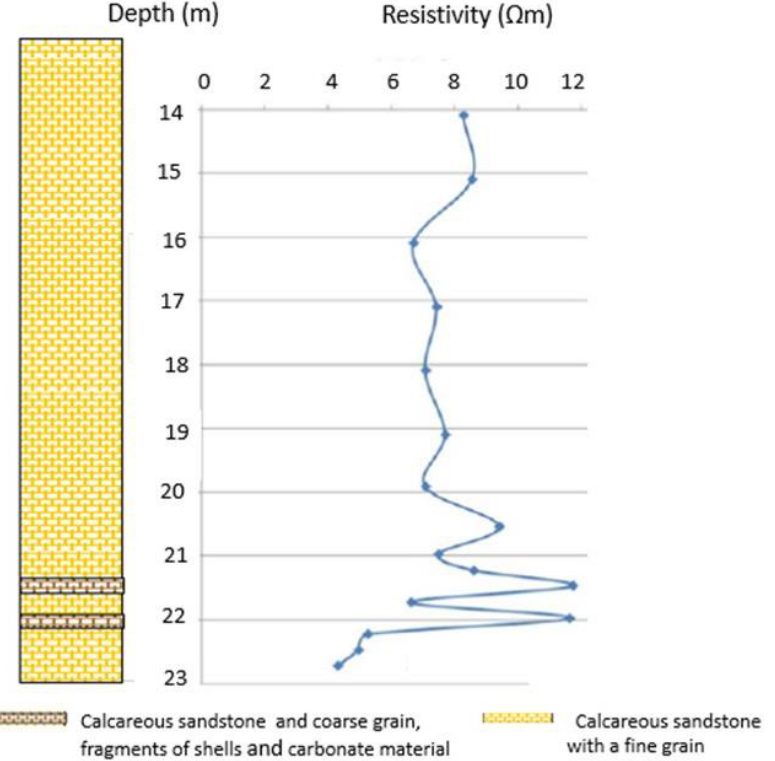
Figure 5. Electrical resistivity profile from 18/6/14 and a geological log in well 71-2. Heterogeneity into the calcareous sandstone at depths 21.5 and 22 m. As formation is constant over time, resistivity evolution is only caused by pore water conductivity evolution.